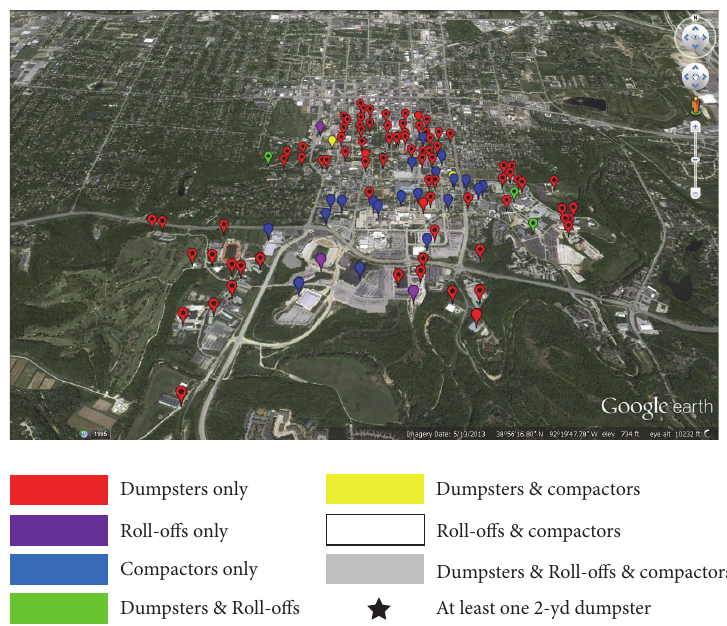
Figure 1: Distribution of receptacles around campus.